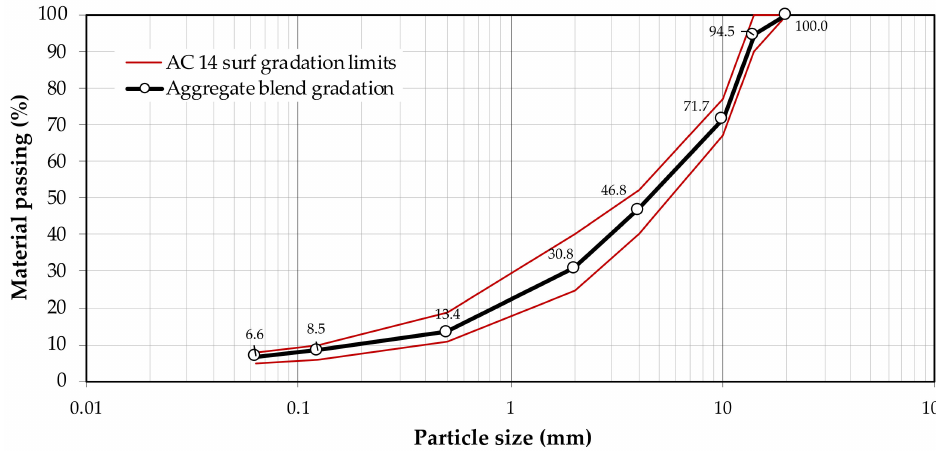
Figure 1. Grading of the aggregate’s mixture and specification gradation limits. Table 1. Physical properties of aggregates and specifications